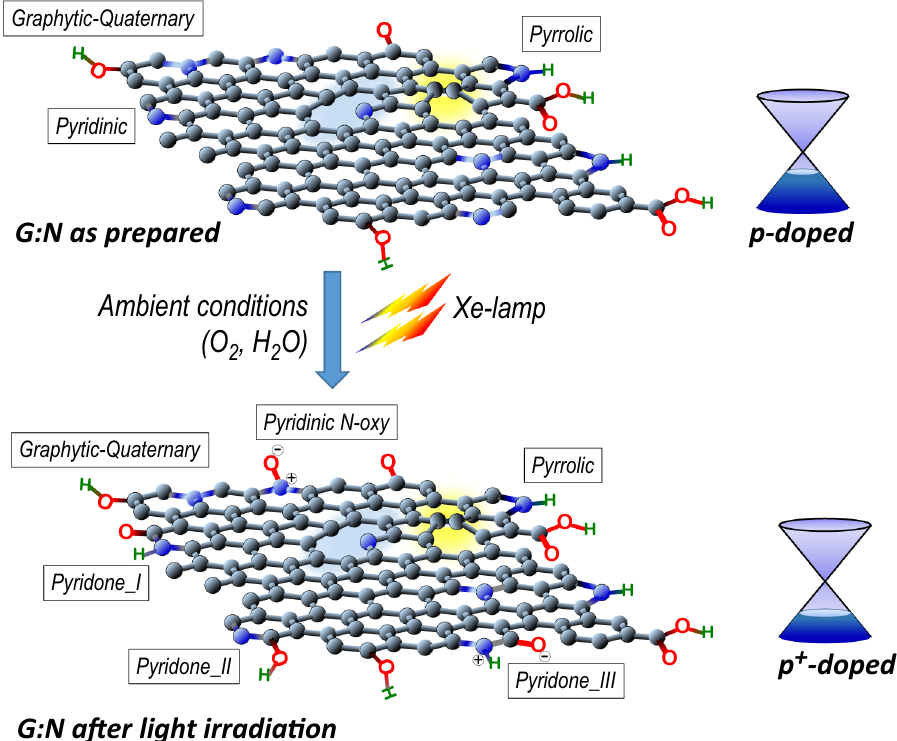
Figure 1. Schematic representation of the N-doped graphene as prepared and after light irradiation under ambient conditions. The blue spheres represent nitrogen atoms. The three different C–N bonding configurations inserted into the graphene network are evidenced in the as prepared G:N, as well as the typical carbon vacancy (blue area) and the Stone–Wales ( yellow area) defects. Following light irradiation, two new functionalities are introduced: Pyridine N-oxide and Pyridone. Among the three different tautomeric forms of pyridone it is emphasized the net charge separation in zwitterion pyridone-III as well as in pyridine N-oxide, thus resulting in a more